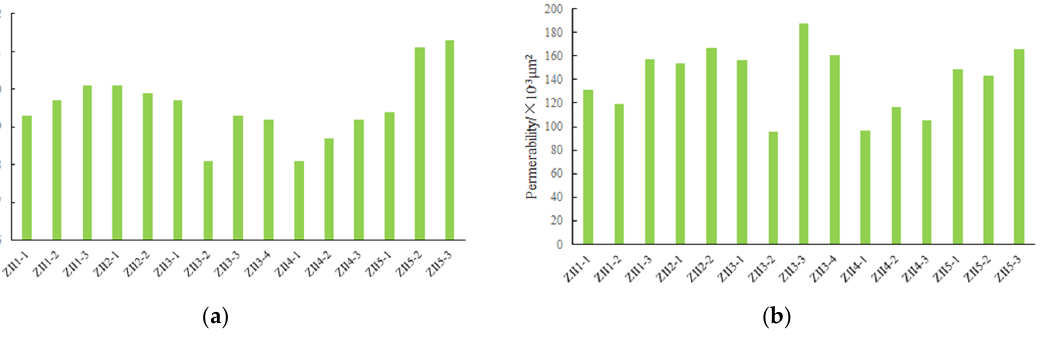
Figure 4. Reservoir properties of sub-sublayers of Z Ⅱ in the Wang Guantun Area. ( a ) porosity; ( b ) permeability.